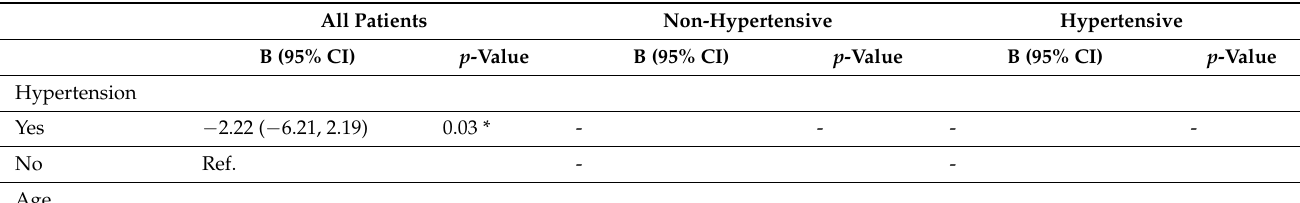
Table 3. Factors Associated with